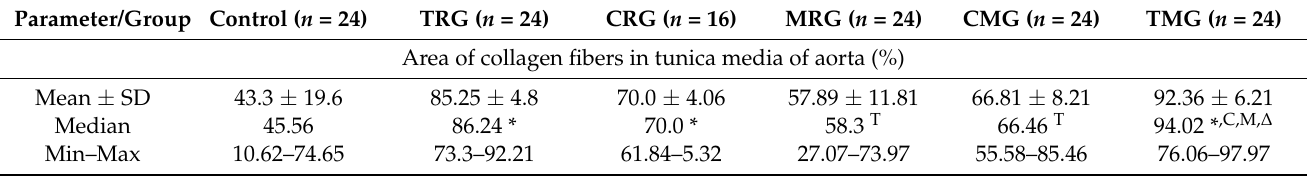
Table 2. Area of collagen fibers in tunica media of aorta in the study groups of